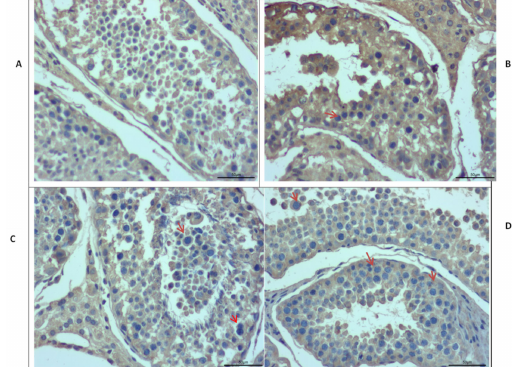
Figure 7. Immunostaining of testis of di ff erent ages in Datong yak. Immunostaining analysis indicated that IZUMO1 is expressed in all ages but positive germ cells (red arrow) are more prominent in the tubules of 30 months and 6 years yak testis compared to 6 months and 18 months. ( A ) 6 months of Datong yak. ( B ) 18 months of Datong yak. ( C ) 30 months of Datong yak. ( D ) 6 years of Datong